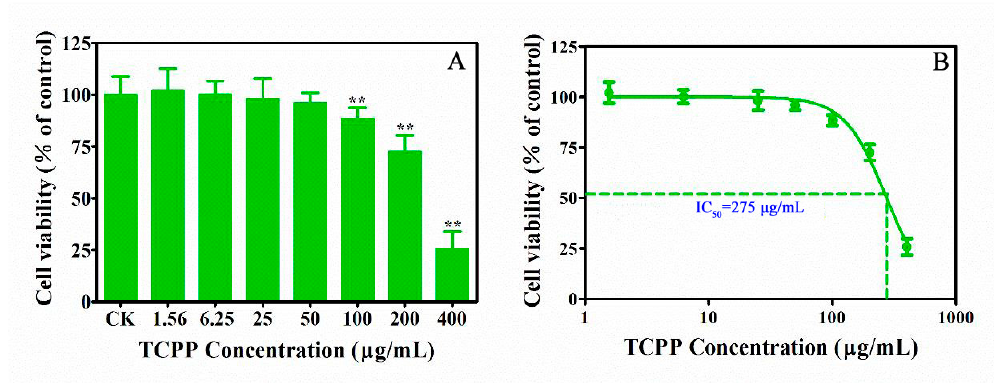
Figure 1. Cytotoxicity of TCPP on HaCaT cells after exposure to 1.56–400 µ g/mL TCPP for 24 h ( A ) and logarithmic transformation of TCPP concentrations and cell viability data to determine IC 50 ( B ). ** p < 0.01.